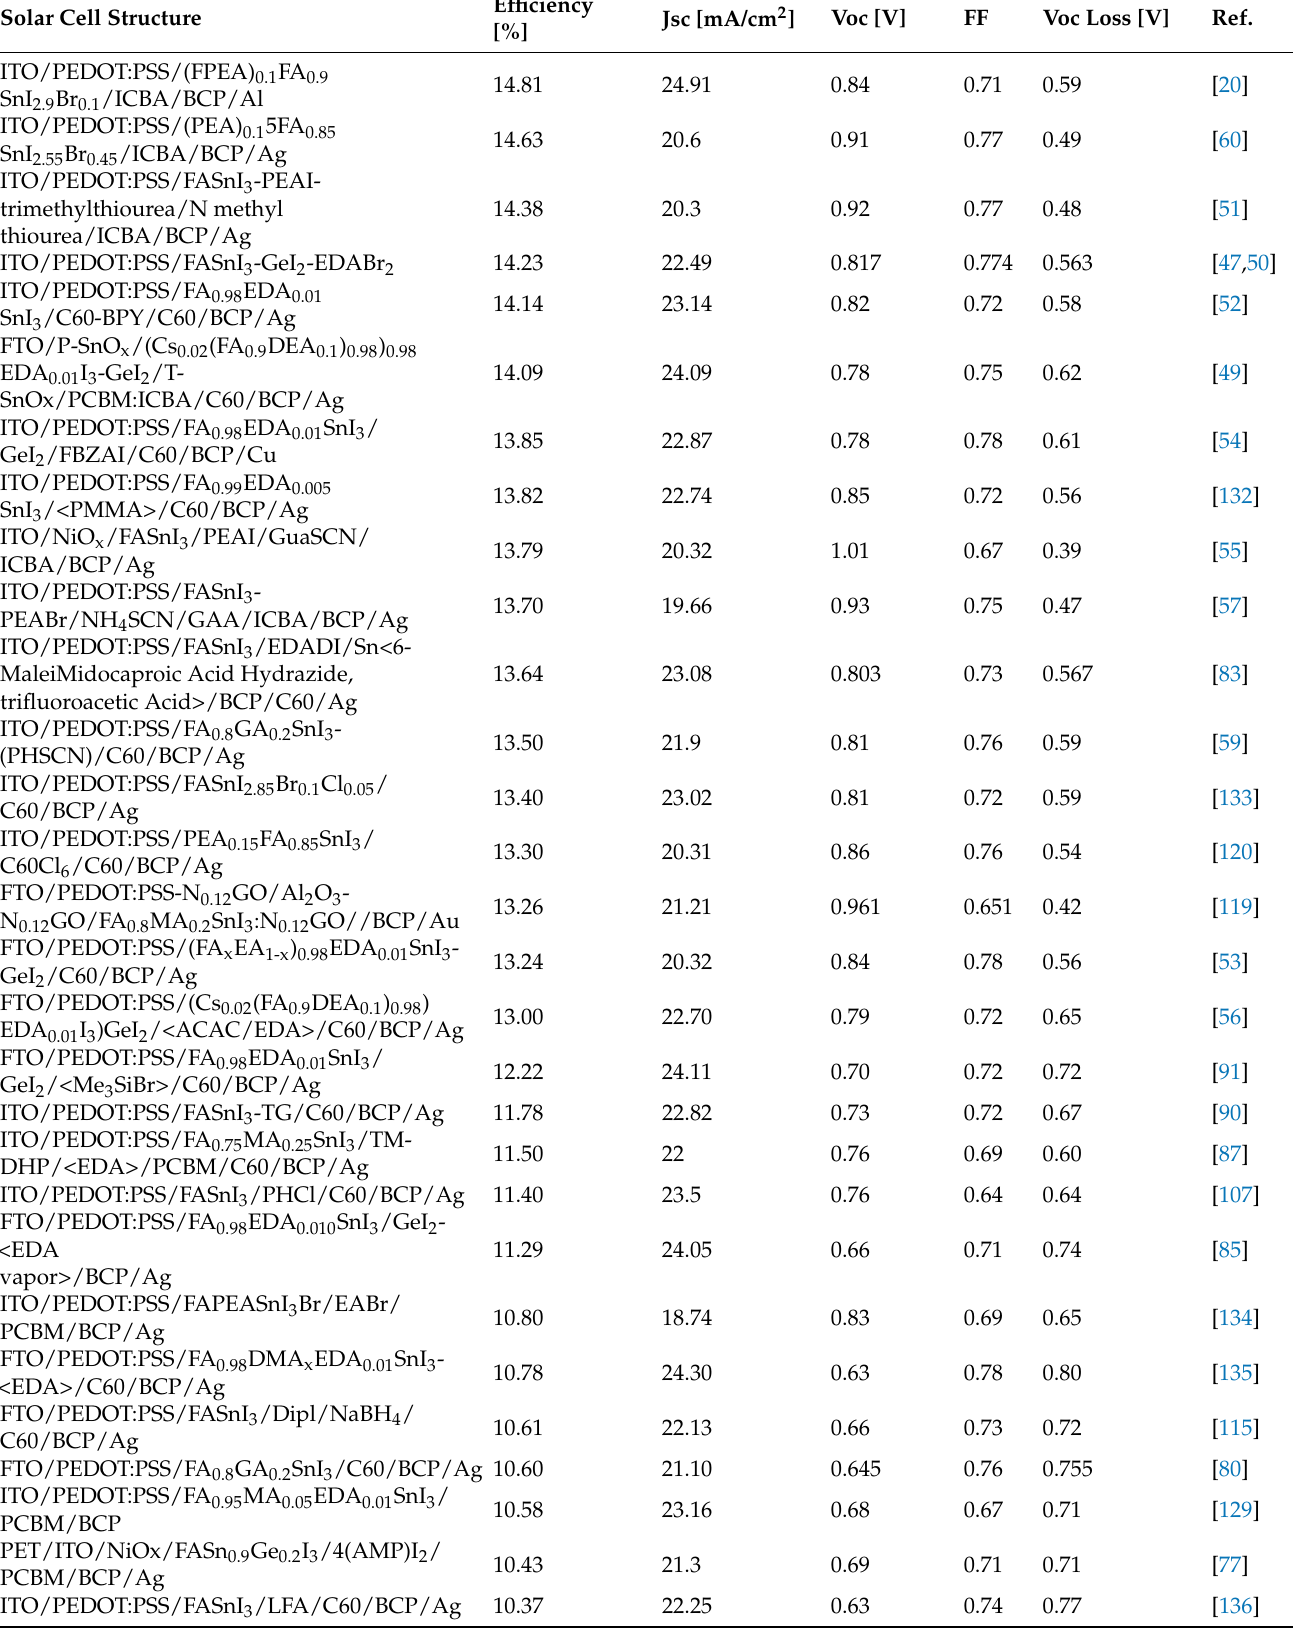
Table 5. The photoelectric performance summary of Sn-perovskite solar cells with >10% efficiency. Solar Cell Structure